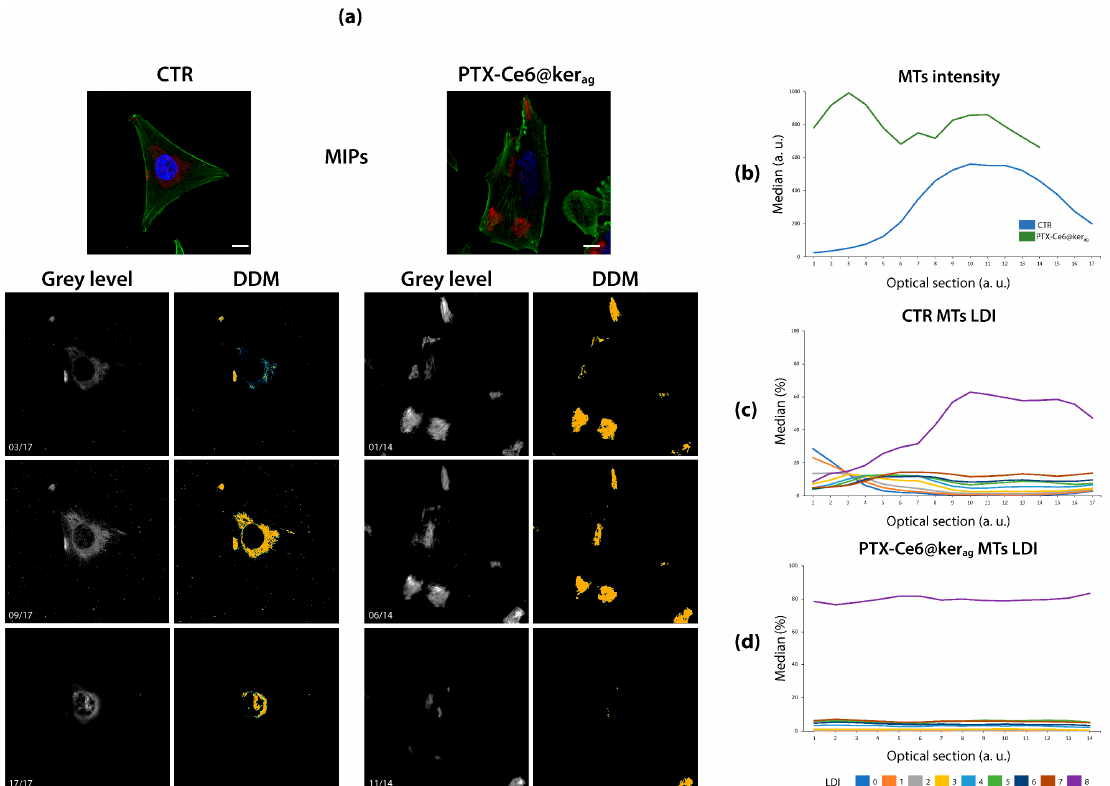
Figure 4. DDMs disclose hidden distribution properties. ( a ) Top: RGB MIPs of MG-63 untreated (left) or exposed to PTX- Ce6@kerag nanoparticles (right) cells, stained for DNA (blue) and actin (green), and immunolabeled against and β -tubulin (red). Bottom: exemplificative optical sections (left) and DDMs (right) of β -tubulin signal distribution along Z -axis. Line plots of MTs median intensity ( b ) and percentage LDI distribution in CTR ( c ) and PTX-treated cells ( d ) along the Z -axis. In PTX presence, MTs are brighter (+126% on average, p < 10 − 5 ), denser (+69%, on average, p < 10 − 5 ) and more present at a high density through the sections (average CV through sections for LDI = 8: 0.02). Scale bars: 10 µm.